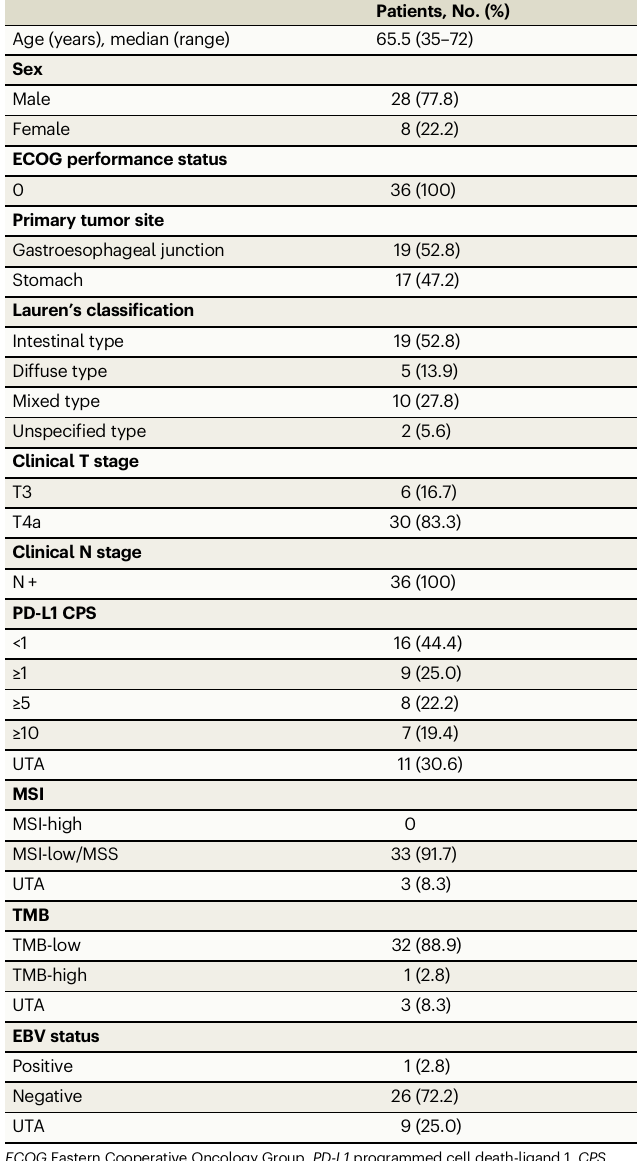
Table 2 | Pathological Patients, No. (%)